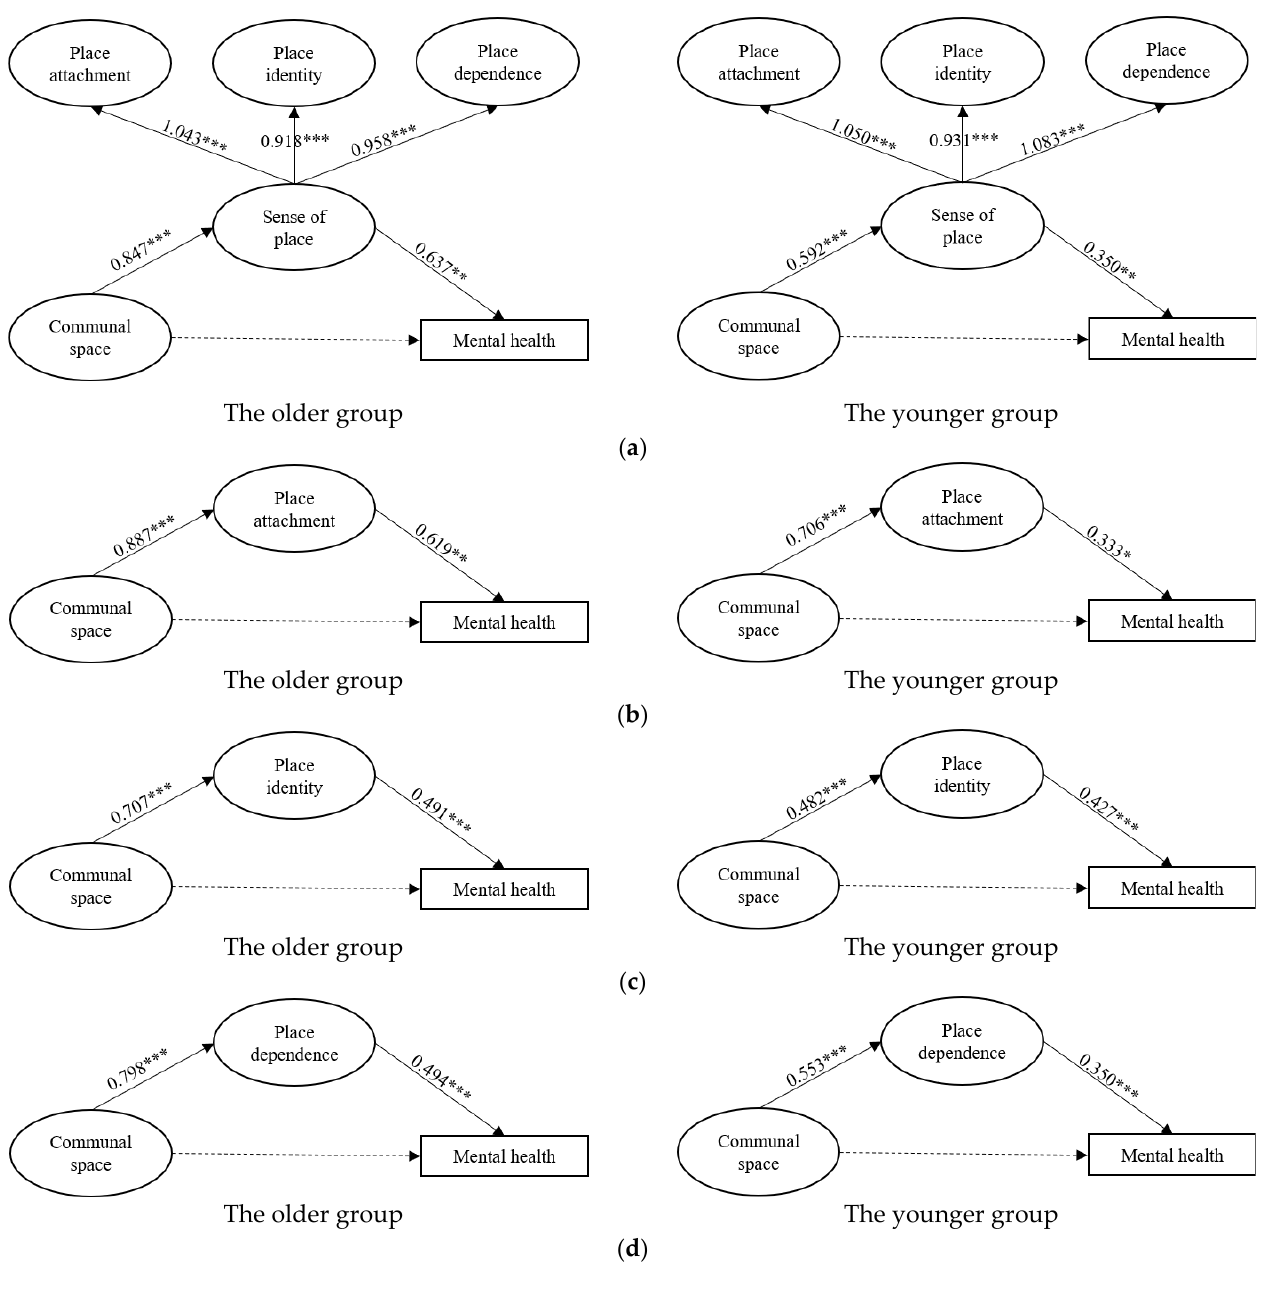
Figure 4. Pathways of model 5 – 8. ( a ) Model 5: Pathways of communal space linking sense of place and mental health in HK; ( b ) Model 6: Pathways of communal space linking place attachment and mental health in HK; ( c ) Model 7: Pathways of communal space linking place identity and mental health in HK; ( d ) Model 8: Pathways of communal space linking place dependence and mental health in HK. *** p < 0.001, ** p < 0.01, * p < 0.05; the solid line is the significant path, but the dotted line is not.